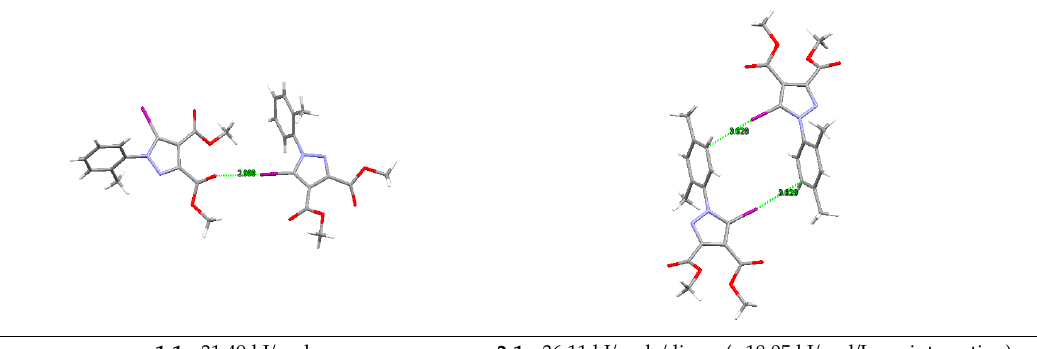
Table 4. Halogen bond interaction dimers and their calculated energies .